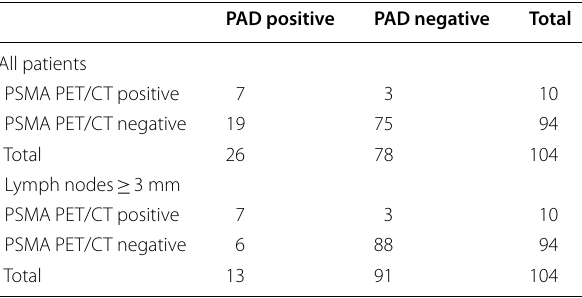
Table 3 Lymph node status from histopathology report (PAD) and by [ 18 F]PSMA-1007 PET/CT for all patients and if gold standard was lymph node 3 mm (number of patients) ≥